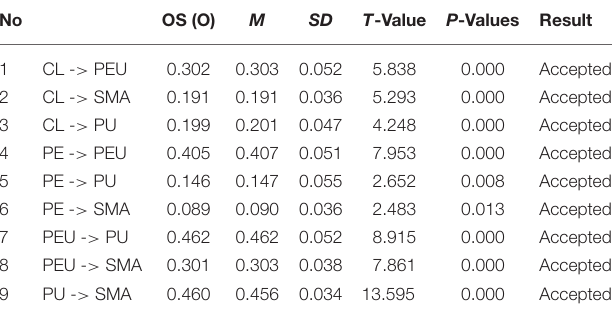
TABLE 6 | Path coefficient